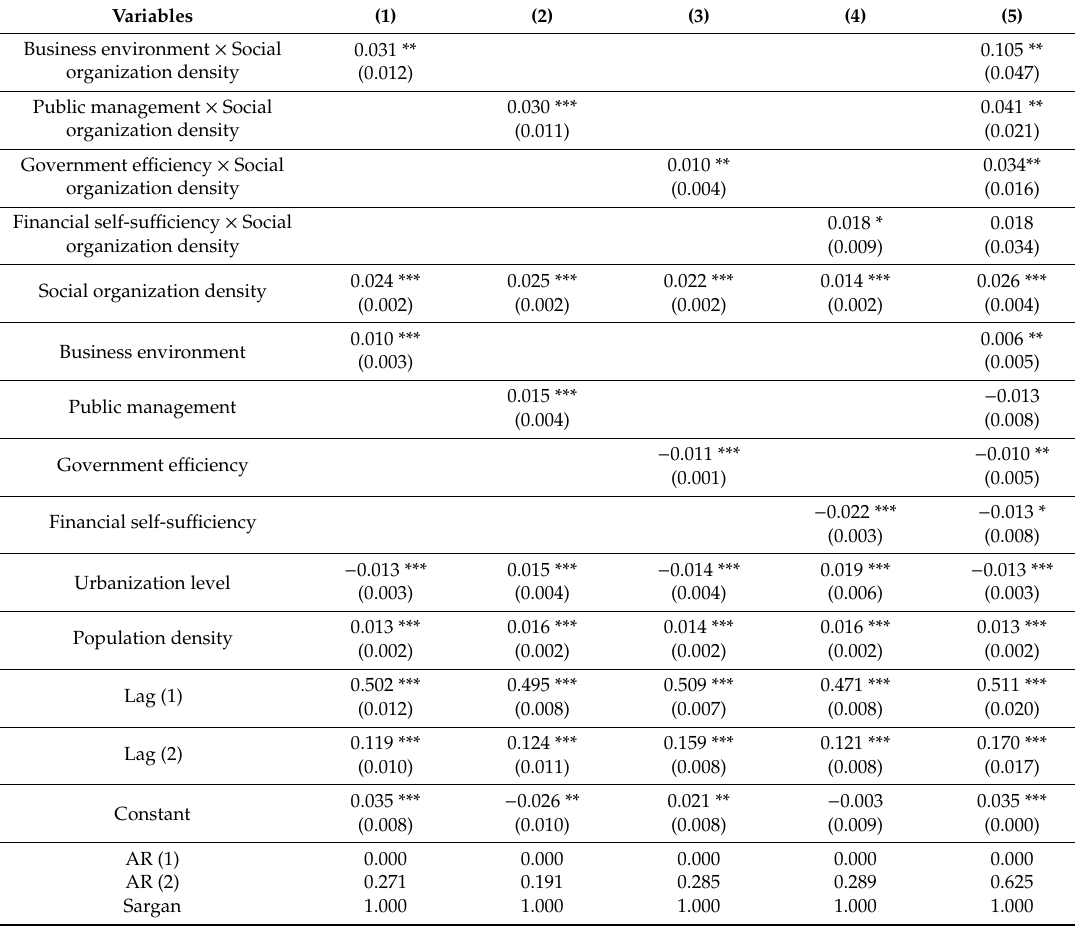
Table 7. Interaction between the government governance and social organization